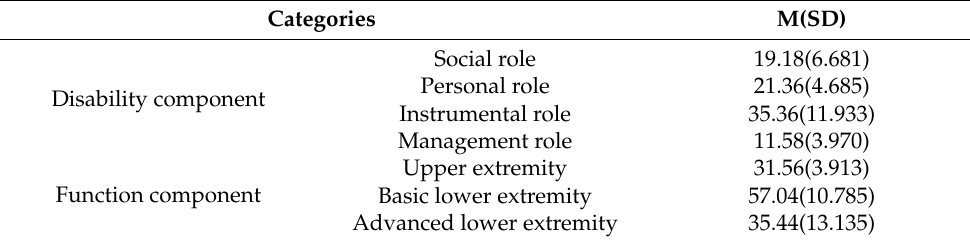
Table 1. K-LLFDI mean score and standard deviation per component ( n =